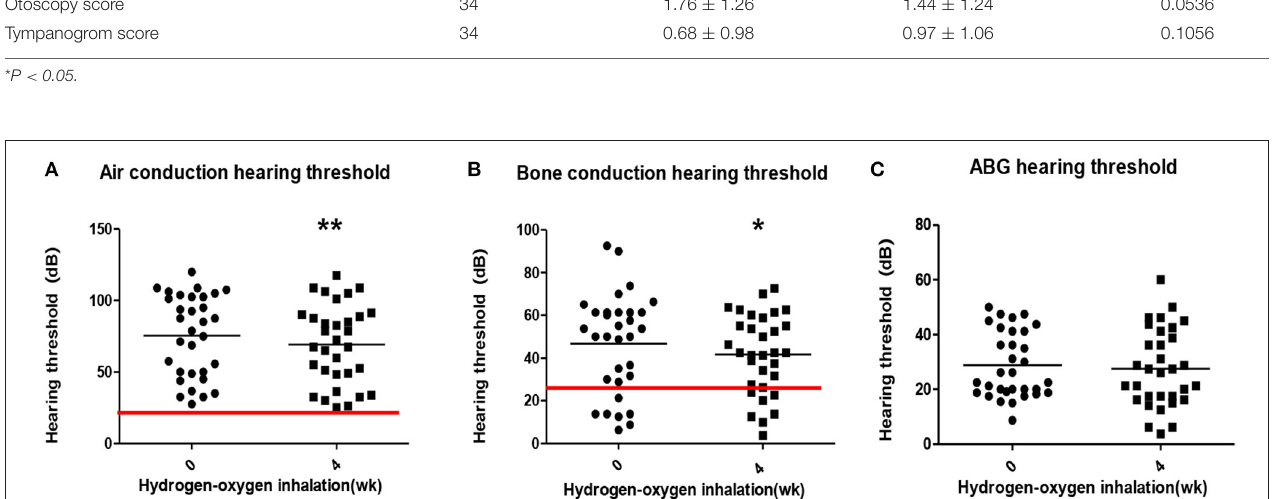
Frontiers in Medicine |